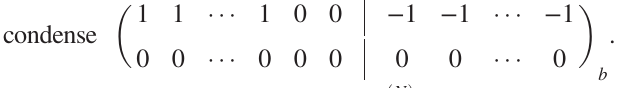
TABLE III. Projective symmetry actions on the topological sectors of the Z 2 TO that realizes the I ð N Þ anomaly of root 1. In the row corresponding to I ð N Þ , the two entries represent the